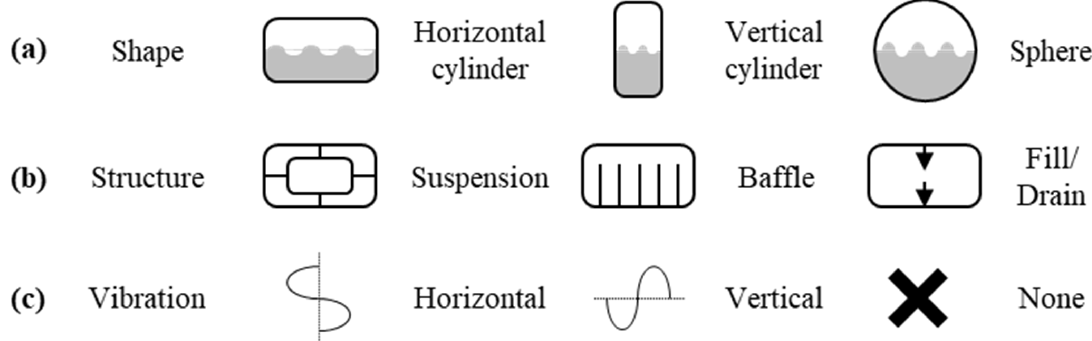
Figure 6. Analysis conditions: ( a ) shape, ( b ) structure, and ( c ) vibration (sloshing).